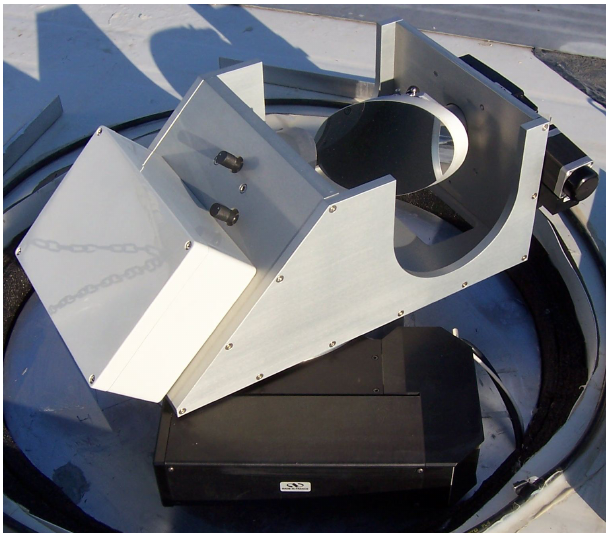
Figure 2. The completed tracker (Lauder, New Zealand) installed at roof level on a tower mounted to the concrete laboratory